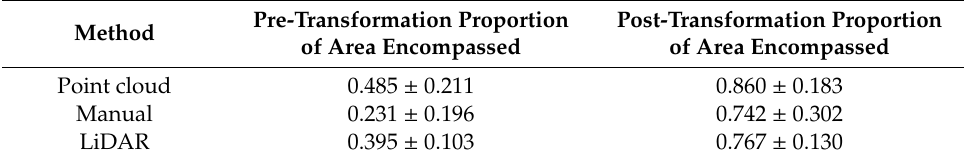
Table 1. Proportion of true lateral vegetation area encompassed by predictions for pre-transformed and post-transformed vegetation height predictions.